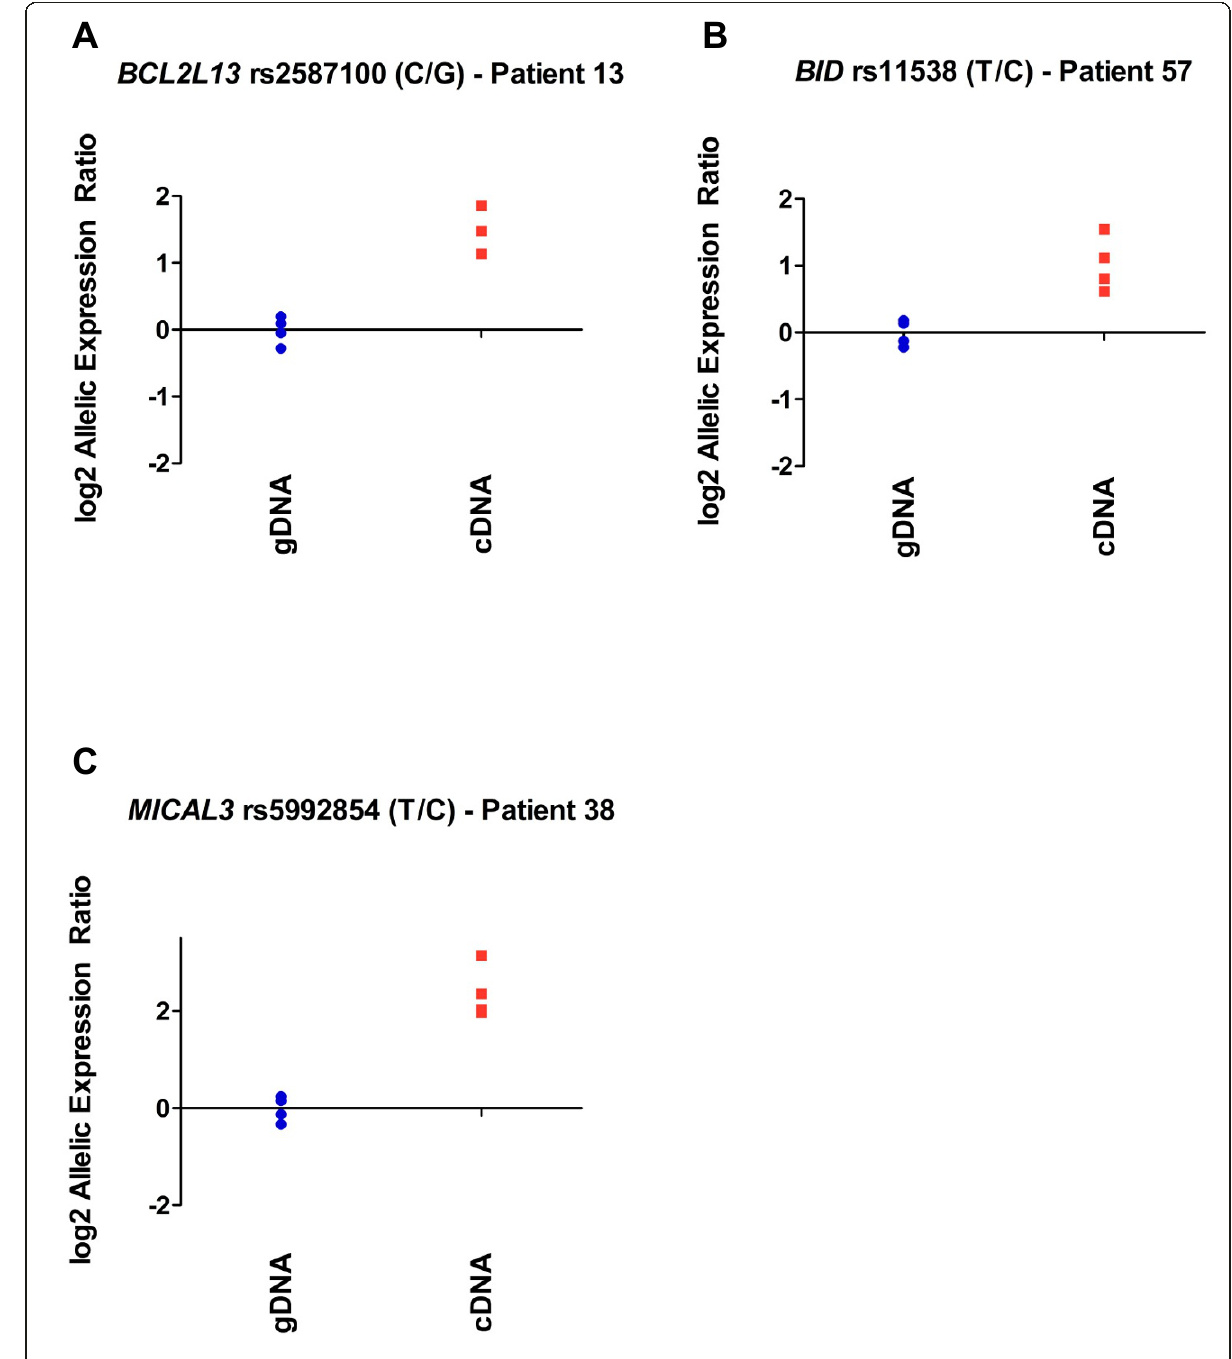
Figure 3 Allelic expression imbalance in patients who showed the largest allelic ratios at BCL2L13, BID and MICAL3 . Data points represent log2 of the normalised allelic ratio of genomic or cDNA for each replicate. A value of 0 on the Y-axis denotes an allelic ratio of 1:1. (A) Patient 13 demonstrated a 2.82 fold greater expression of the C allele relative to the G allele (P = 0.004) at BCL2L13 SNP rs2587100, (B) patient 57 demonstrated a 2.09 fold greater expression of the T allele relative to the C allele (P = 0.001) at BID SNP rs11538, (C) patient 38 demonstrated a 5.47 fold greater expression of the T allele relative to the C allele (P = 0.001) at MICAL3 SNP